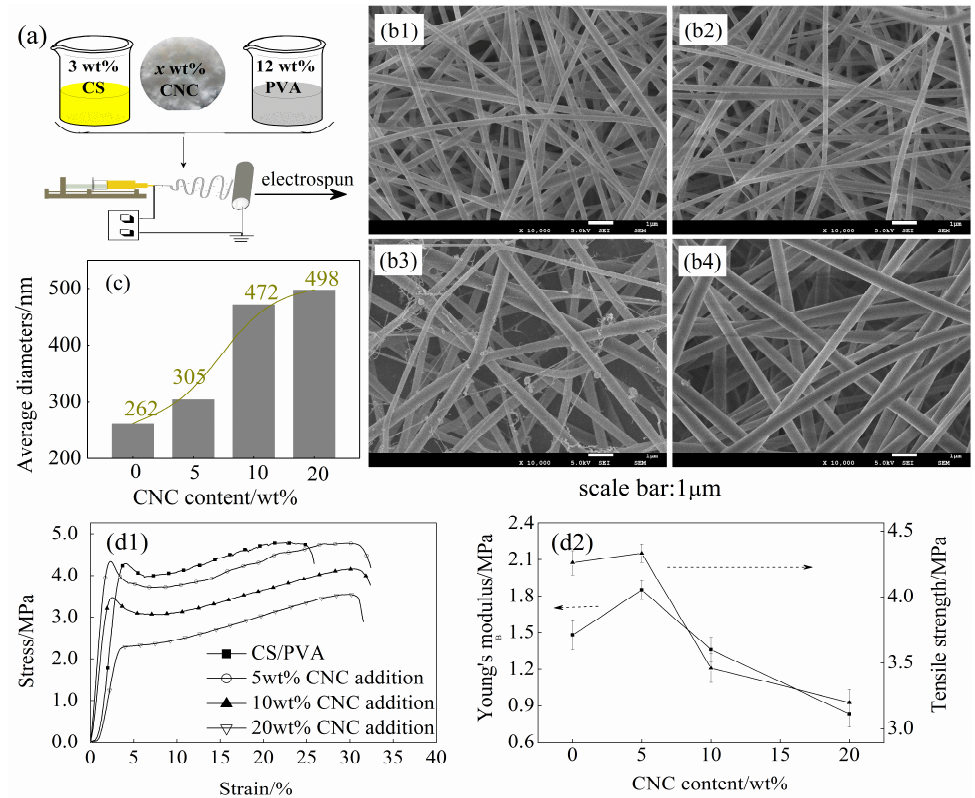
Figure 3. Electrospun cellulose nanocrystals/chitosan/polyvinyl alcohol (CNC/CS/PVA) composite nanofibrous films ( a ) Schematic diagram of preparation process; ( b1 – b4 ) Surface morphology